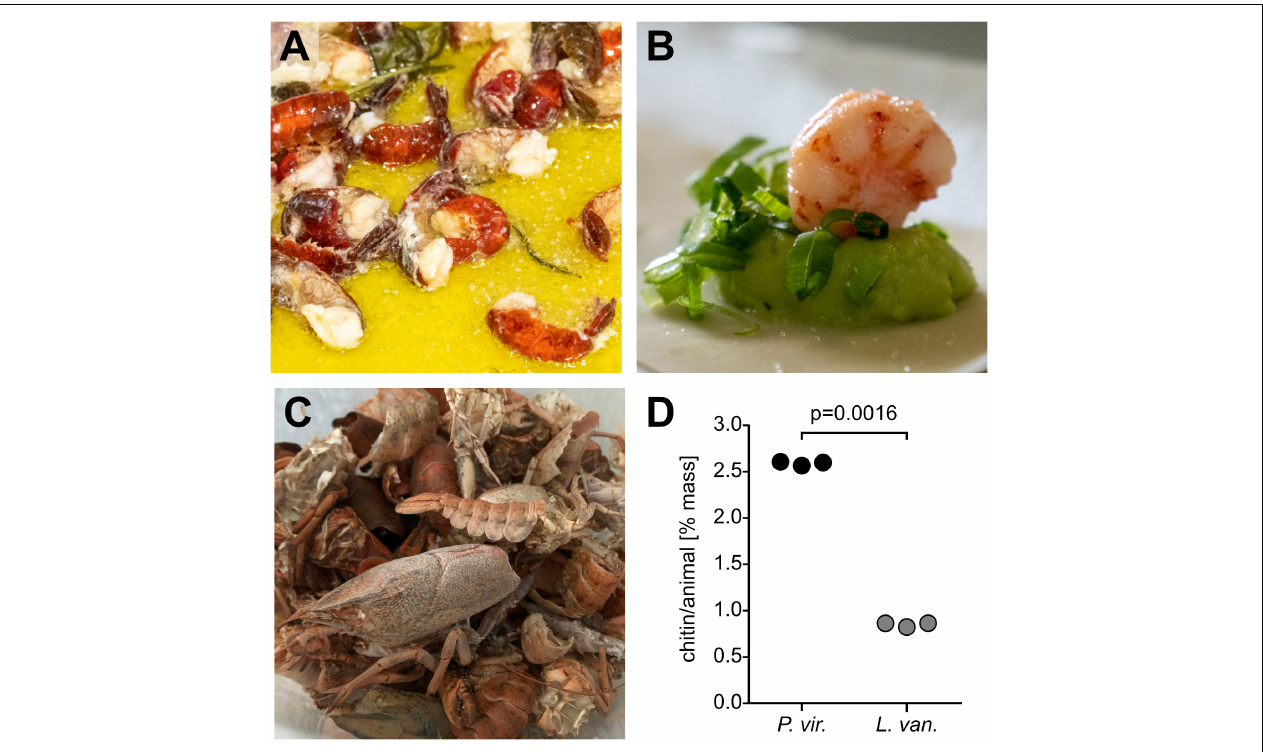
FIGURE 4 | Utilization of marbled crayfish as a source for dietary protein and chitin. (A) Marbled crayfish tails with herbs, fried in butter. (B) Marbled crayfish tail meat on Avocado mousse. (C) Dried exoskeletons (shell waste) from marbled crayfish. (D) Comparison of chitin content per animal in marbled crayfish ( P. vir ) exoskeletons and whiteleg shrimp ( L. van ) shell waste. An unpaired two-tailed t -test showed that the difference between the two groups is highly significant ( p =